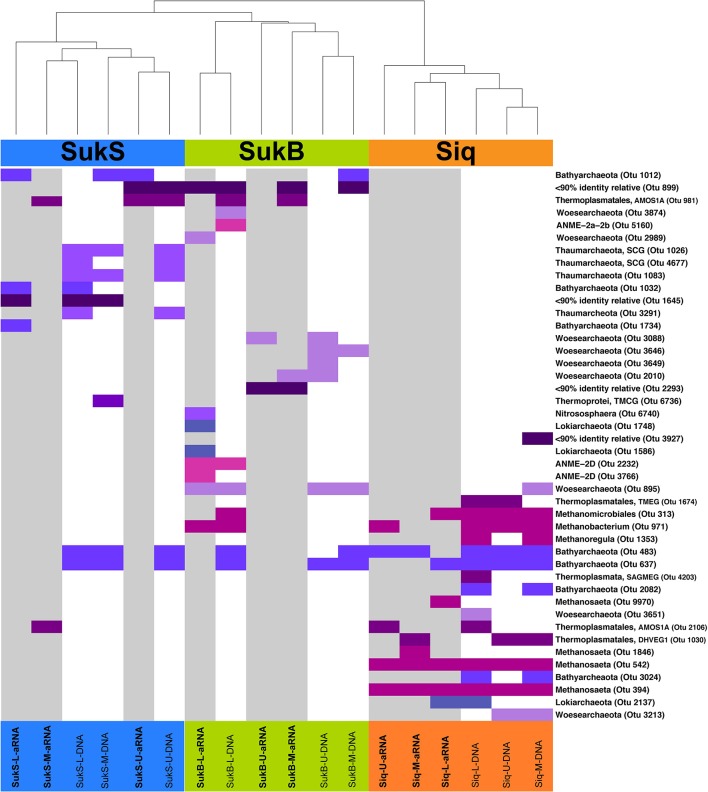
Two-dimensional hierarchical clustering (average linkage) analysis of iTag OTUs based on non-parametric Spearman's rank correlations. Abundances were rank-transformed within each resampling. Average neighbor clustering of average rank correlation was used to order OTUs and samples. Only OTUs that were observed in >95% of re-sampled datasets are shown. Sampling sites are shown in color at the top of the graph along with dendogram showing clustering relationship between the sampled aRNA or DNA where SukS samples are in blue, SukB in green, and Siq in orange. The presence of different Archaeal OTUs are shown by colored bars, with those samples represented by aRNA shown with a gray background. Different archaeal phyla are indicated by different shades of blue to purple colors. Different groups of Euryarchaeota (All methanogen-related OTUs, Thermoplasmatales, and ANME OTUs were also indicated by different colors magenta, dark purple, and pink, respectively. Taxonomic affiliation was confirmed by phylogenetic analysis of their closest neighbors (mostly > 97% identity) in the Silva Database (123).